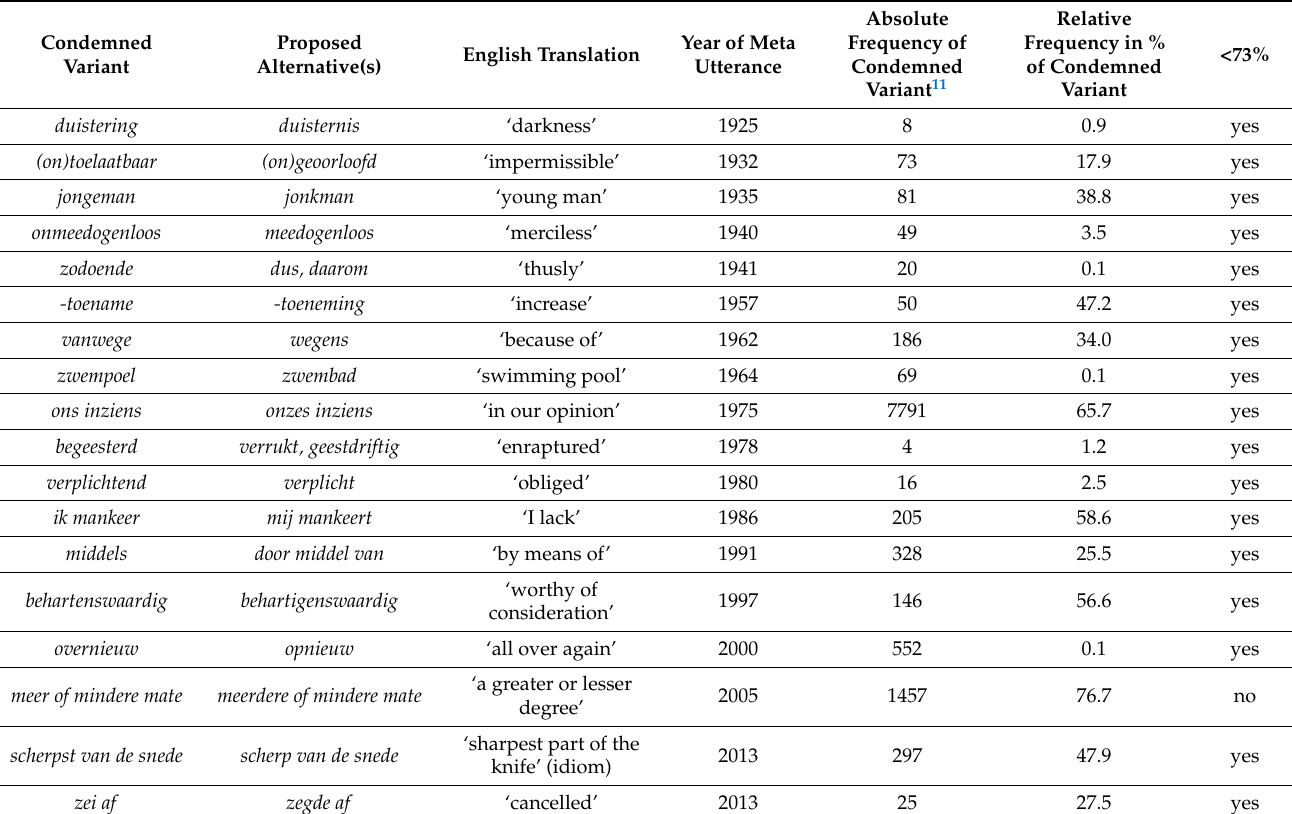
Table 8. Lexical usage items with year(s) of prescriptive utterance, absolute and relative frequency counts of condemned variant in usage, and evaluation with regard to Frequency Illusion.